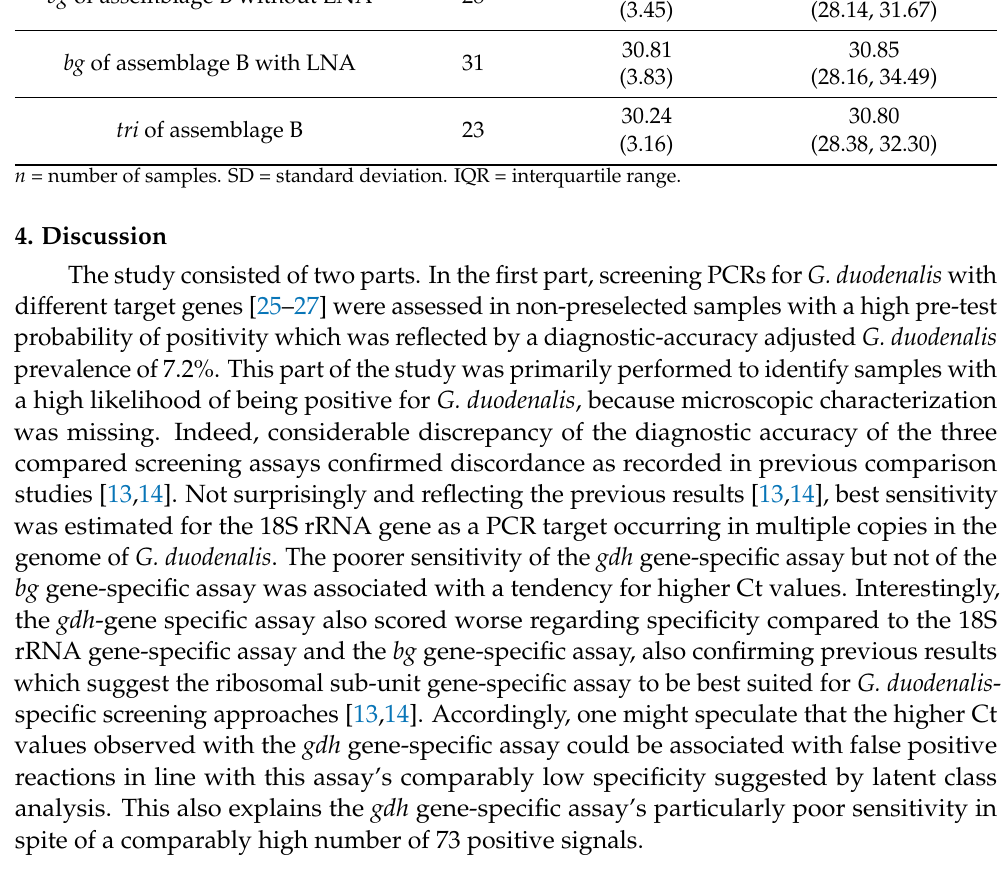
Table 4. Recorded cycle threshold (Ct) values of the assemblage-specific PCR assays. Assay n Mean (SD) Median (IQR) bg of assemblage A without LNA